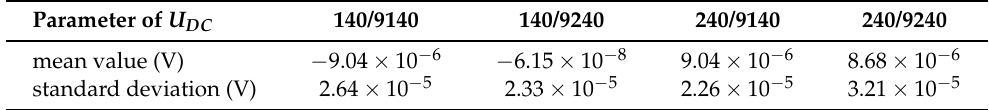
Figure 11. Voltage U DC measured at load R0 with input capacitors C7 and C8 shorted to ground for: ( a ) 140/9140; ( b ) 140/9240; ( c ) 240/9140; and ( d ) 240/9240 transistor pairs. Table 3. Numerical data for Figure